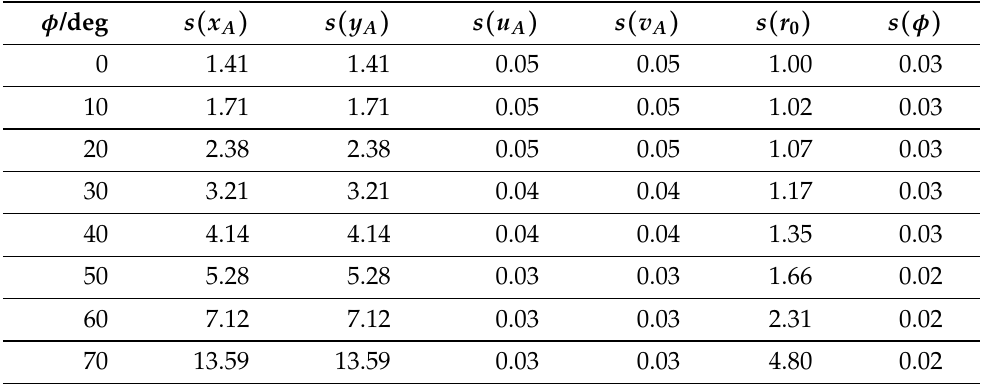
= σ 2 I , the uncertainties X R